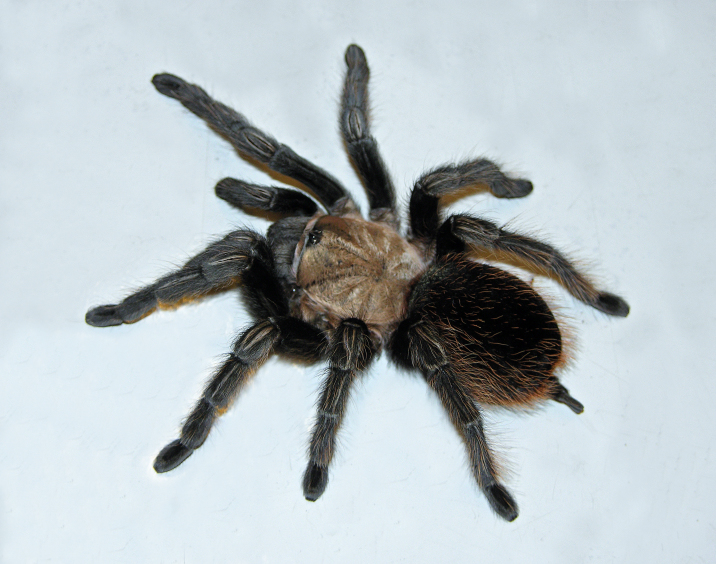
Brachypelma
verdezi Schmidt, 2003 female, light morphotype from near Chilpancingo, Guerrero state, Mexico. Photo: Rick C. West.